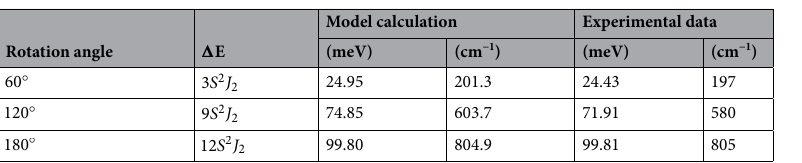
Table 1. Excitation energy values calculated from the model Hamiltonian in the text corresponding to the rotation angles of the three Mn-spins in a trimer in LuMnO 3 single crystal. In the model, S = 2 and J 2 = 2.08 meV (Park, J. et al., Oh, J. et al.) are